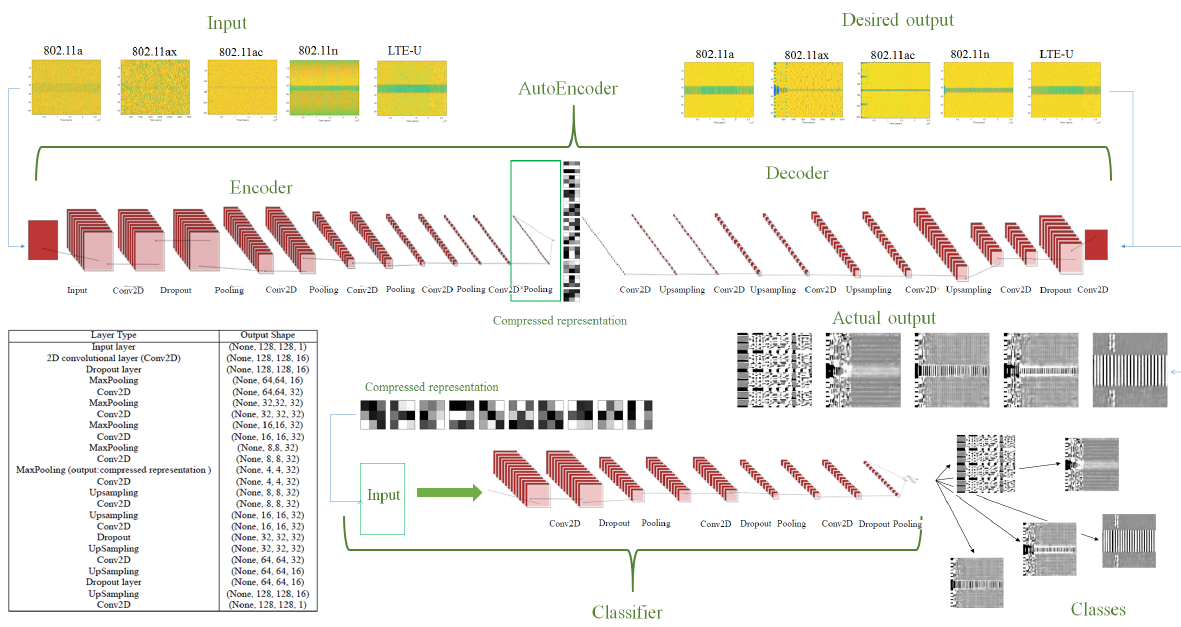
Figure 5. Signal classifier architecture composed of multiple convolutional layers. The classifier’s input is the compressed representation of the denoising autoencoder, and the output is the